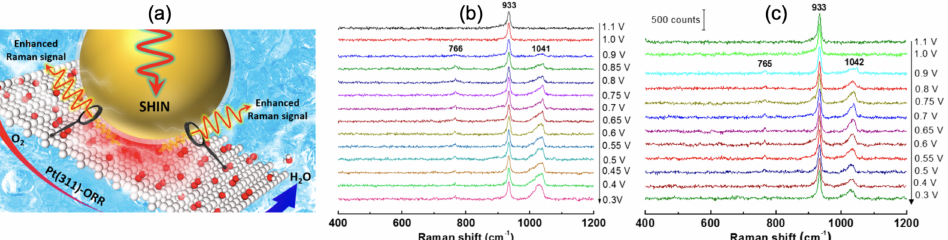
Figure 5. ( a ) Principle scheme of a SHINERS (Au@SiO 2 ) measurement for oxygen reduction reaction on Pt( hkl ) surfaces. For different values of potential, SHINERS spectra recorded in HClO 4 solution (0.1 M) saturated in O 2 are shown for the surfaces of ( b ) Pt(311) and ( c ) Pt(211). All the figures are reprinted (adapted) with permission from [97], Copyright 2020 American Chemical